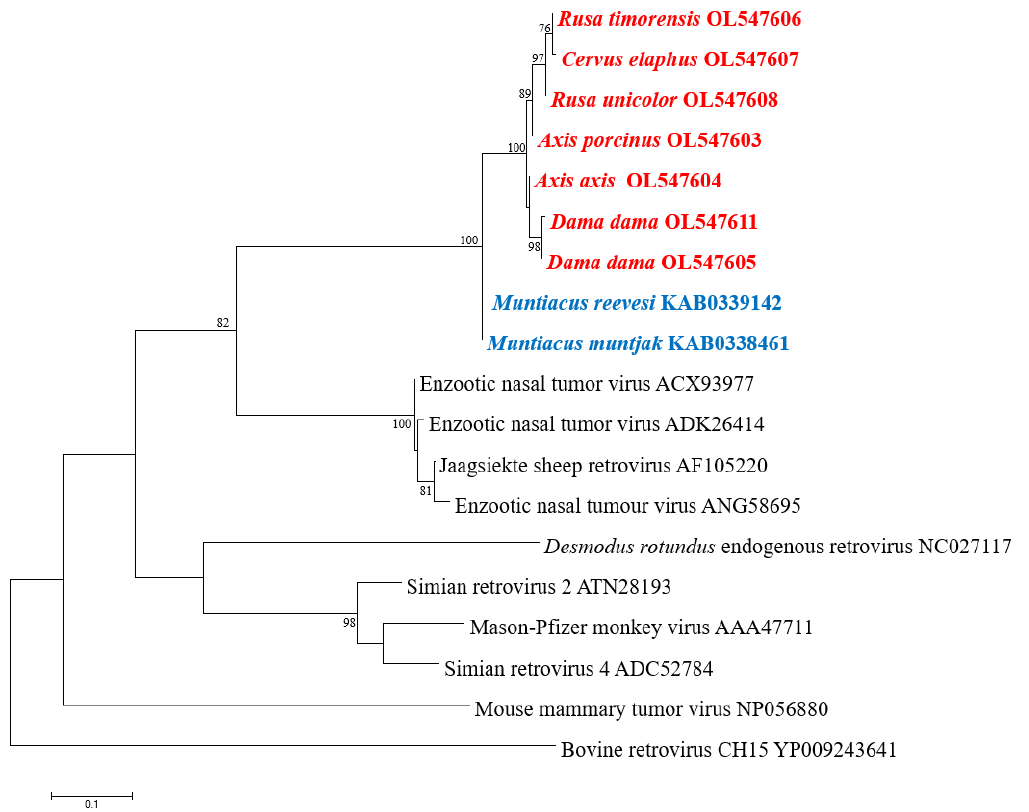
Figure 3. Phylogenetic analysis of partial pol aa sequences. Translated sequences obtained by PCR in members of subfamily Cervinae are in red: chital deer ( Axis axis ), fallow deer ( Dama dama ), hog deer ( Axis porcinus ), red deer ( Cervus elaphus ), rusa deer ( Rusa timorensis ), and sambar deer ( Rusa unicolor ). Sequences of members of subfamily Muntiacinae are in blue. The tree was generated by the maximum-likelihood method based on JTT + G + I substitution model with 1000 bootstrap replicates. Bootstrap values >70% are displayed at the tree branches. The scale bar indicates amino acid substi- tutions per site.